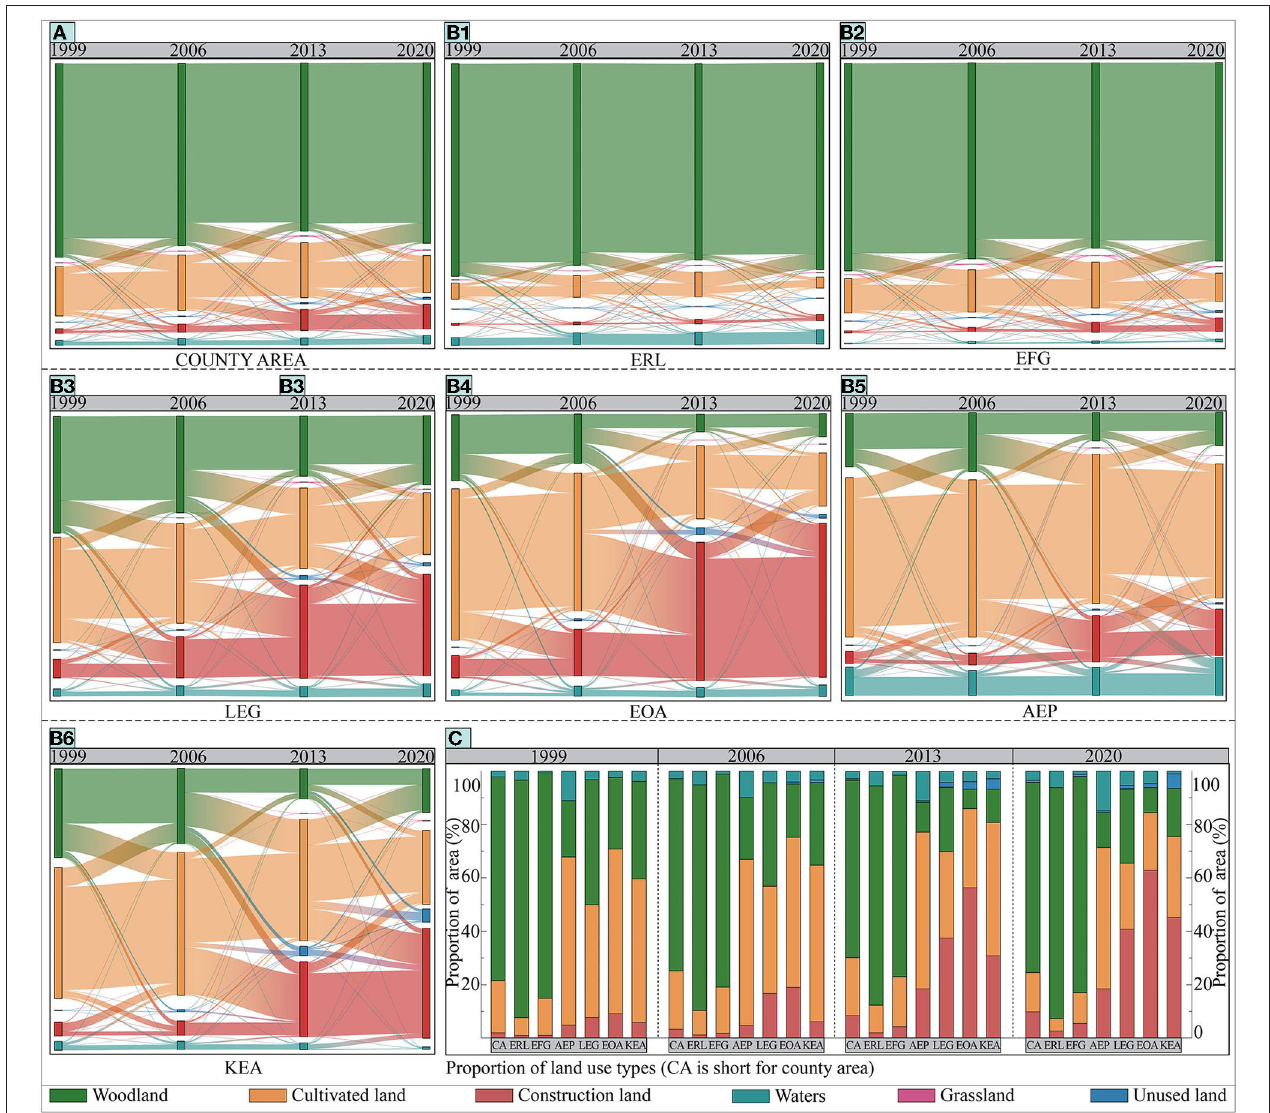
FIGURE 3 | Land use transfer at county scale (A) and in each environmental function region (B) and proportion of land use types at the county scale and each environmental function region (C) . Those below 1% in (C) are not counted.